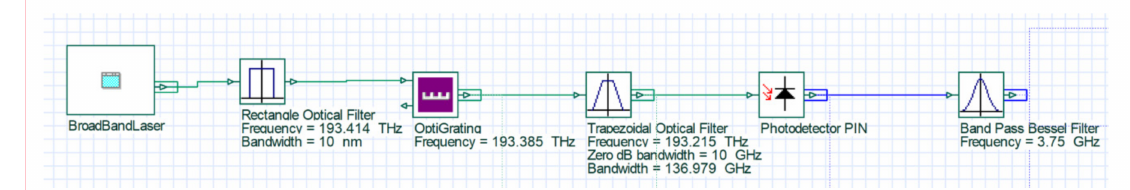
Figure 9. Simulation of the optoelectronic interrogation scheme in the OptiSystem